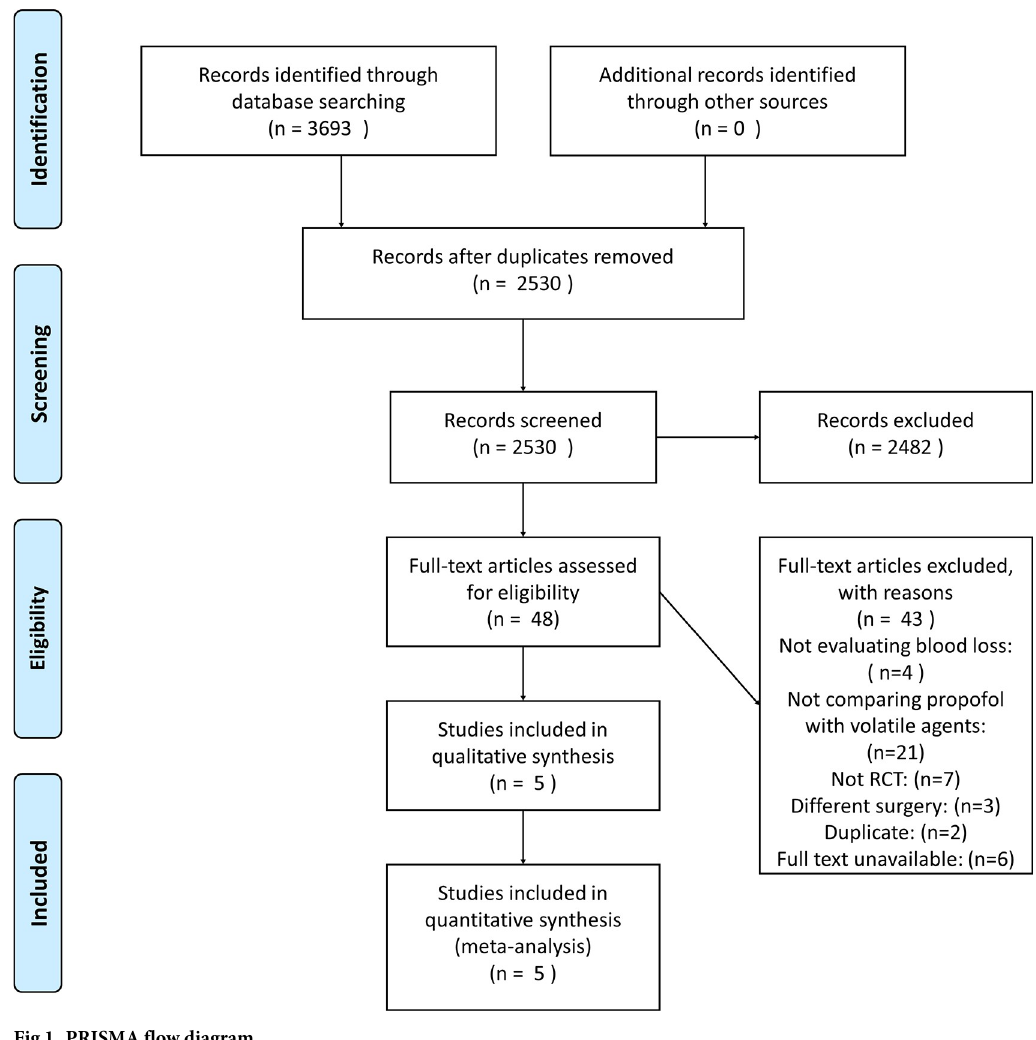
Fig 1. PRISMA flow diagram.